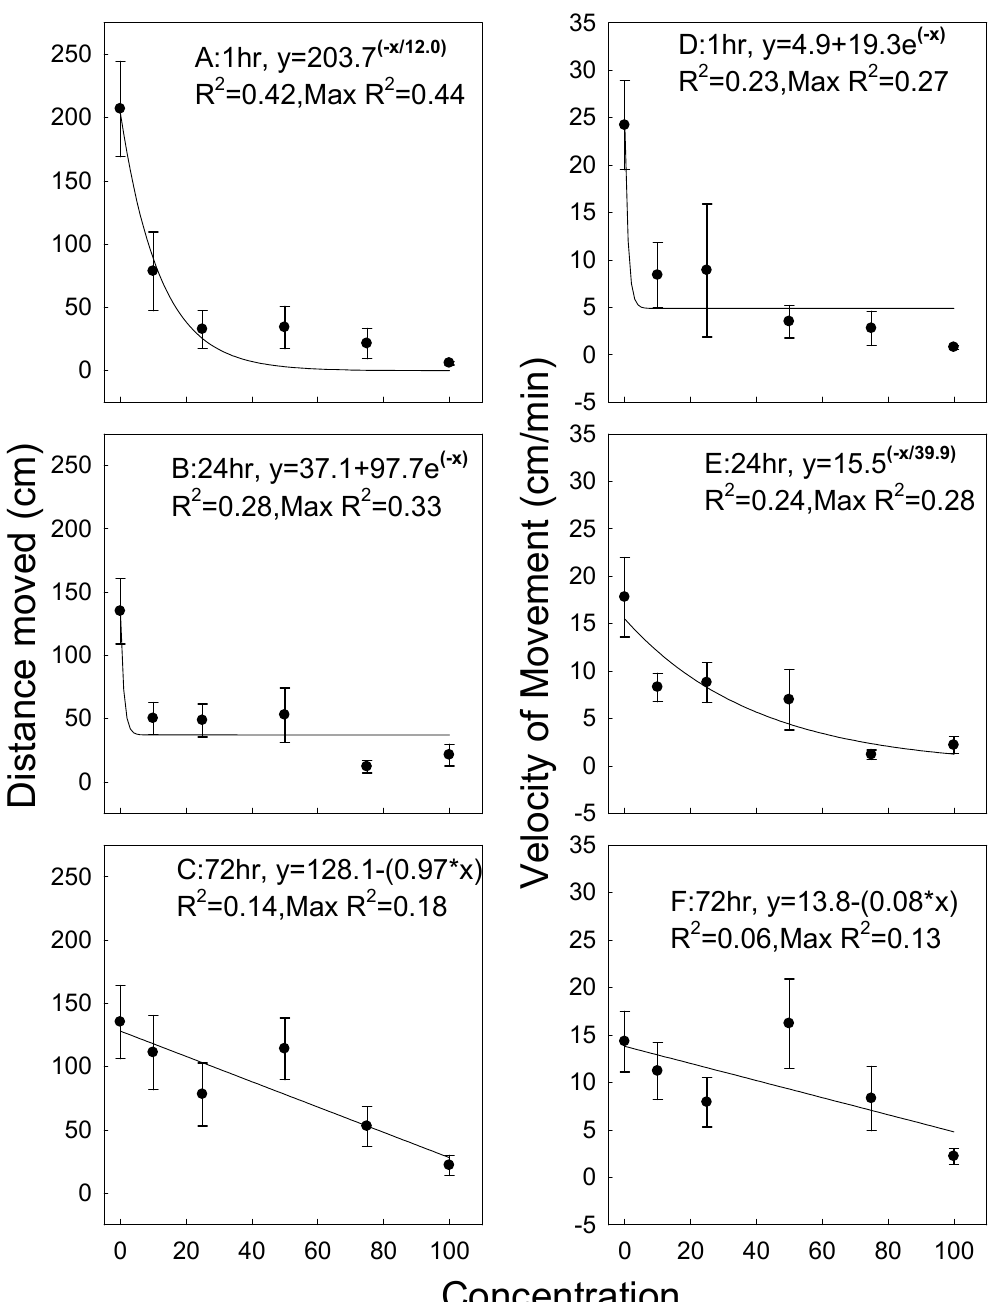
Figure 2. Distance moved for C. ferrugineus exposed for 1, 24, and 72 h on wheat treated with the experimental formulation (Figure 2A–C), and velocity of movement exposed at the same times (Figure 2D–F). Curve-fit lines are as described for Figure 1.